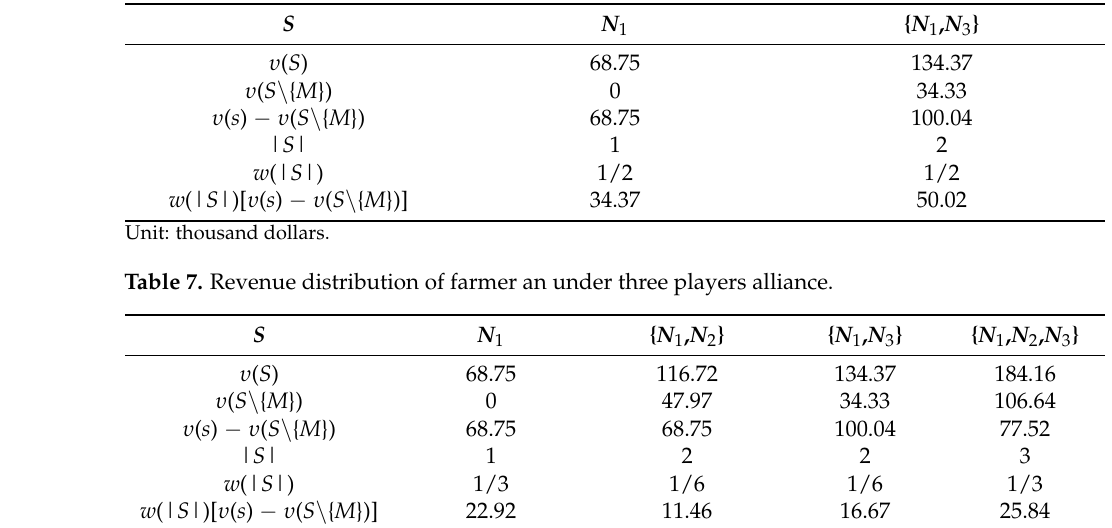
Table 6. Revenue distribution of farmer an under two players alliance.